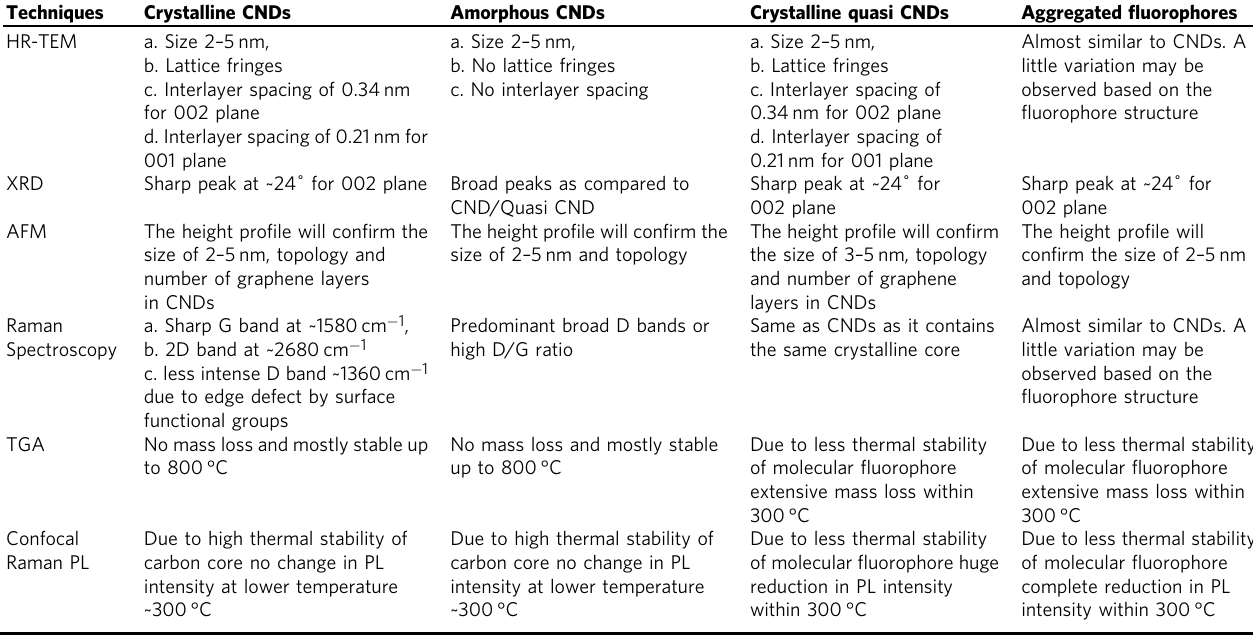
Table 1 Different characterization techniques for identifying pure crystalline CNDs